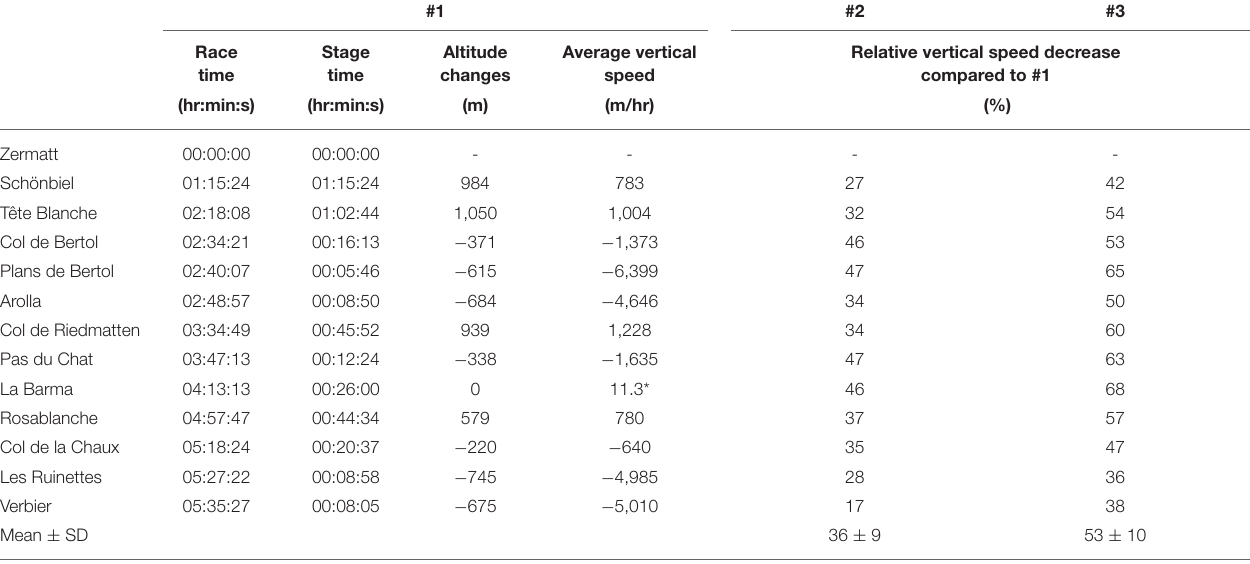
TABLE 2 | Race times.